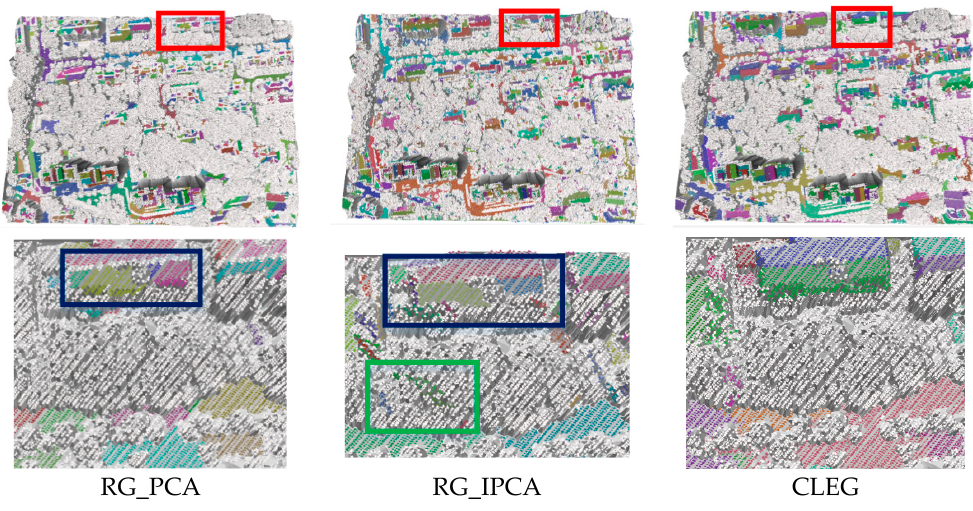
Figure 13. Segmentation results in the Wuhan area using dataset (b).